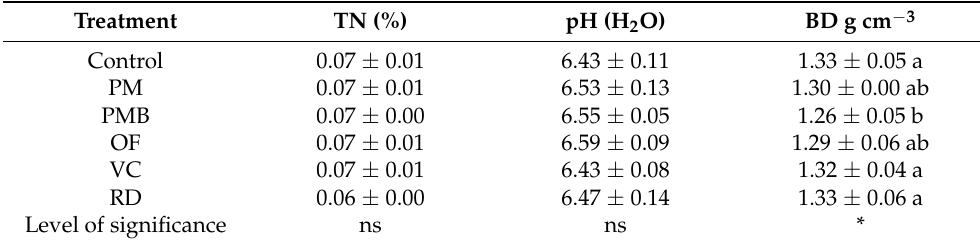
Table 8. Effects of different treatments on physicochemical properties of charland